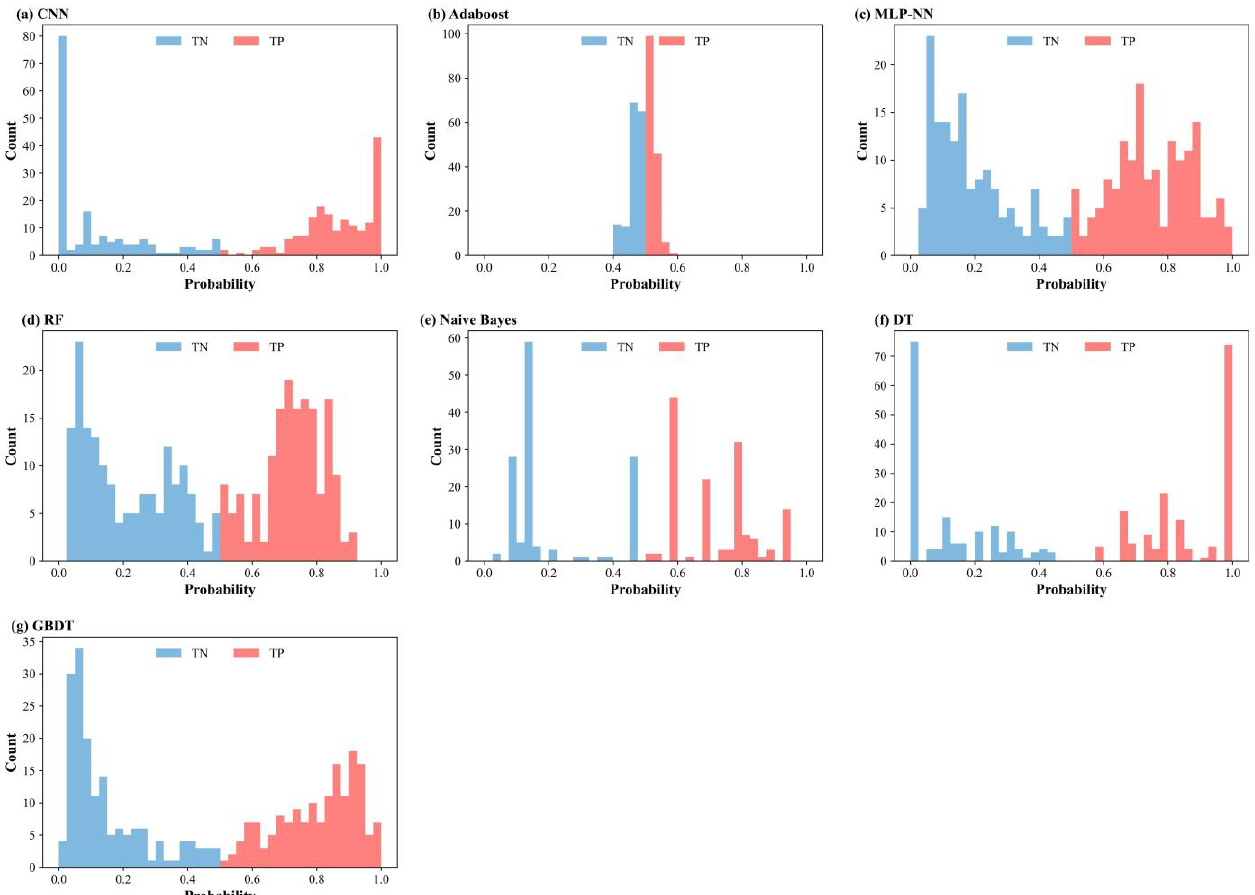
Figure 8. Histograms of the models of the true sample: ( a ) CNN, ( b ) Adaboost, ( c ) MLP-NN, ( d ) RF, ( e ) Naïve naive Bayes, ( f ) DT, ( g ) GBDT.